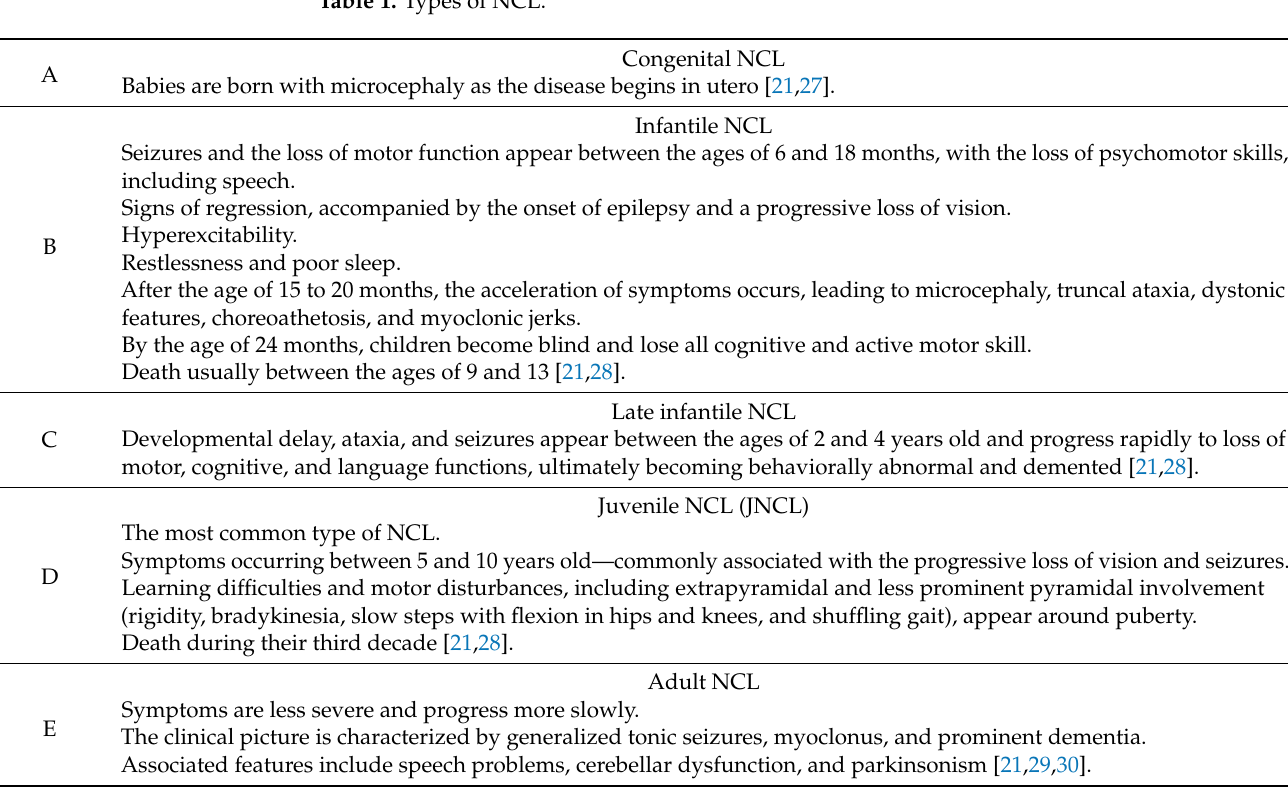
Table 1. Types of